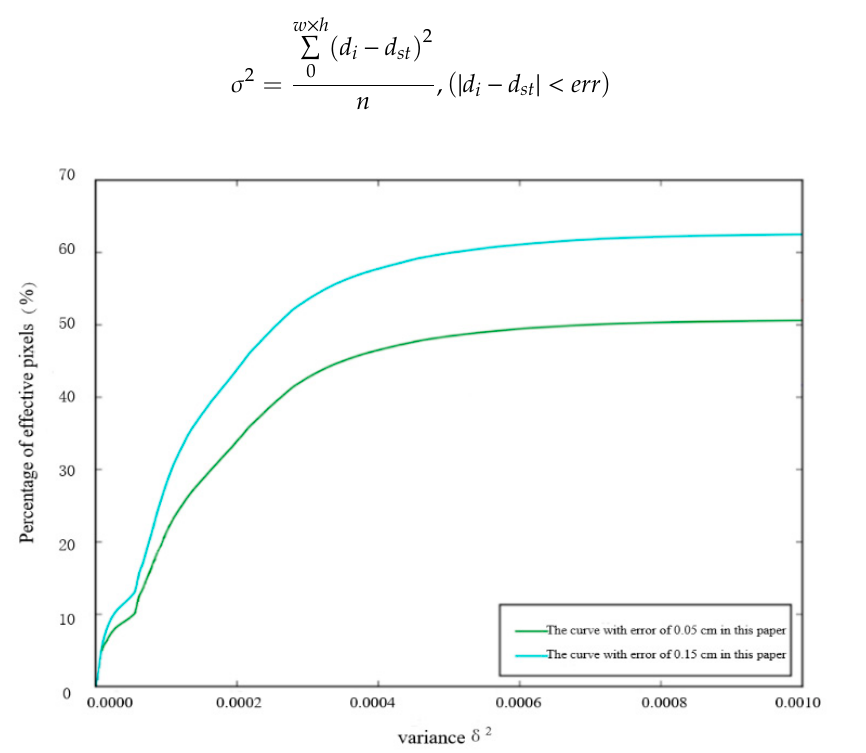
Figure 23. The evaluation results in terms of reconstruction accuracy.